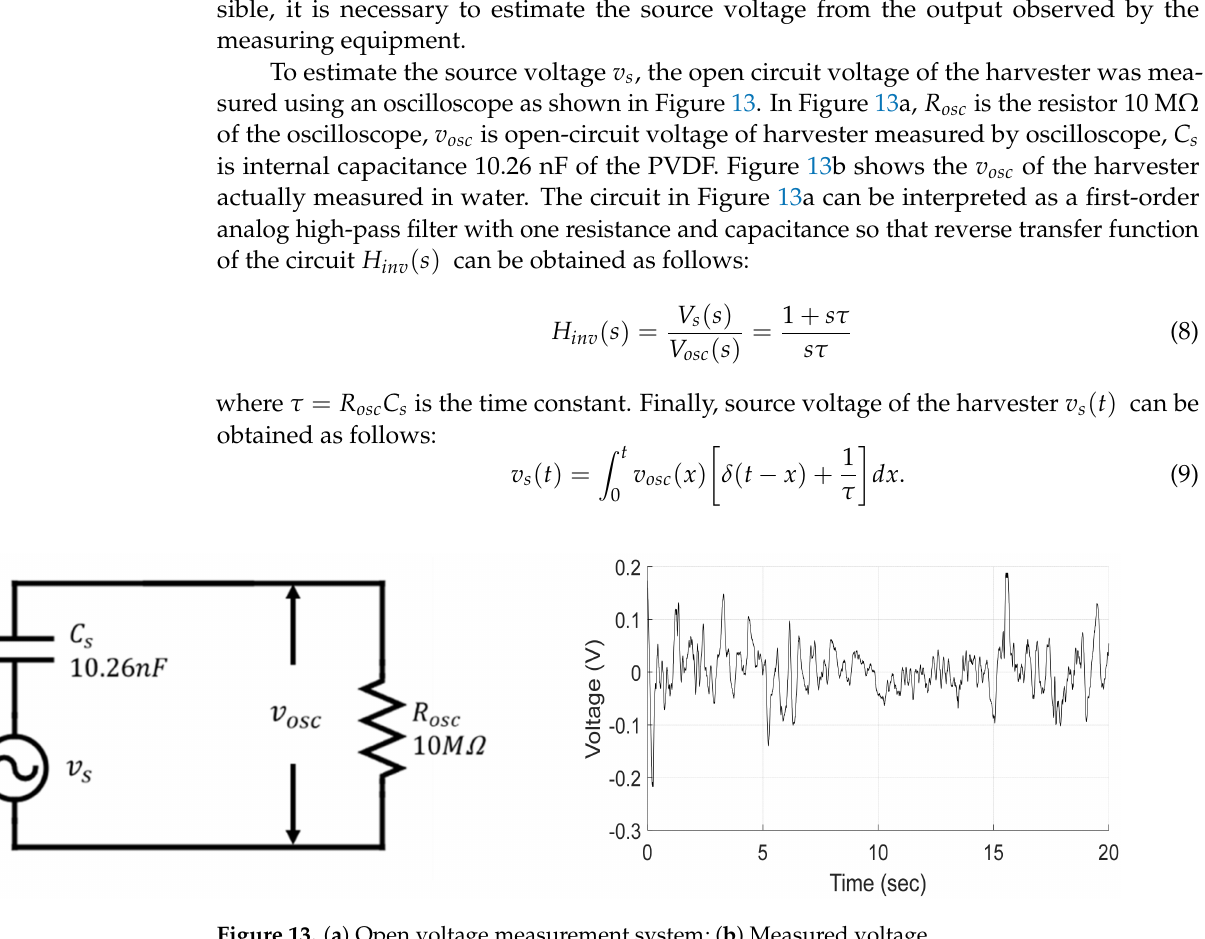
Figure 13. ( a ) Open voltage measurement system; ( b ) Measured voltage.